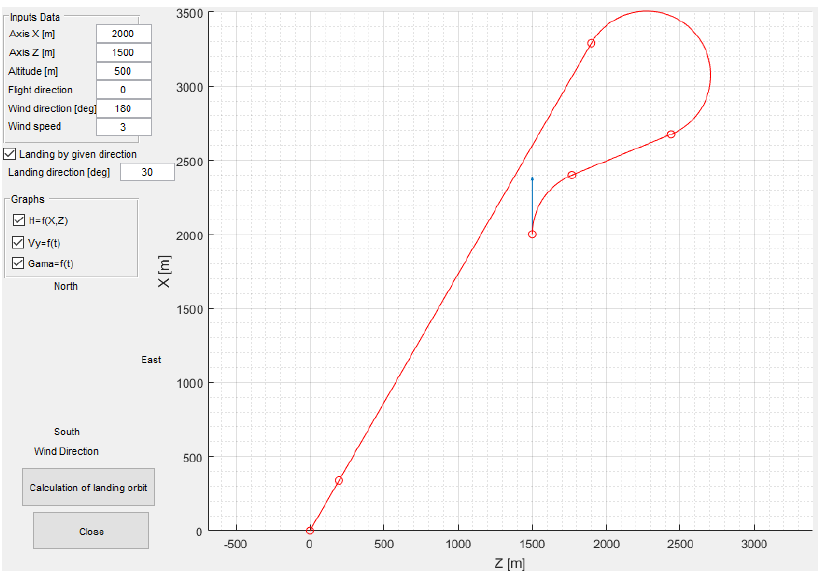
Figure 22. The desired trajectory for UAV landing in the given direction.